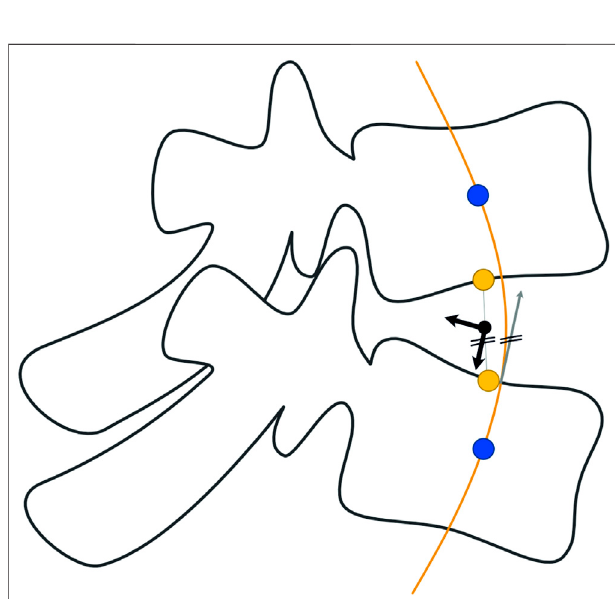
FIGURE 3 | Determination of intervertebral joint location and orientation. The position of the joint is assumed to be the midpoint of the straight line connecting the central points of the endplates. Orientation of the marker is de fi ned via the derivative of intersection of the spline interpolation of vertebral